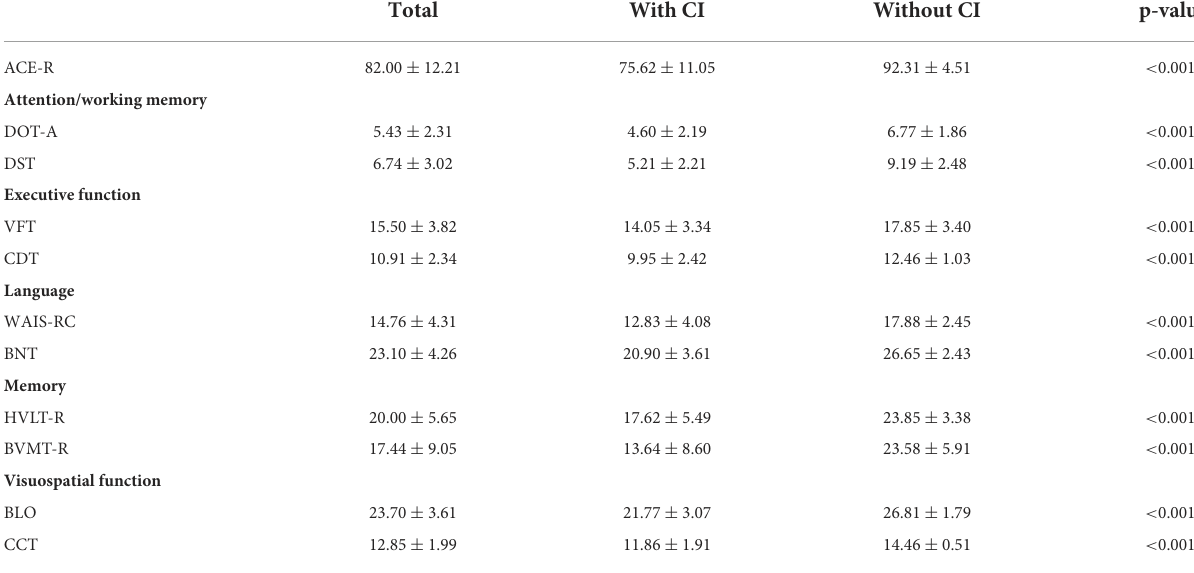
TABLE 4 Cognitive assessments between CD patients with and without CI.